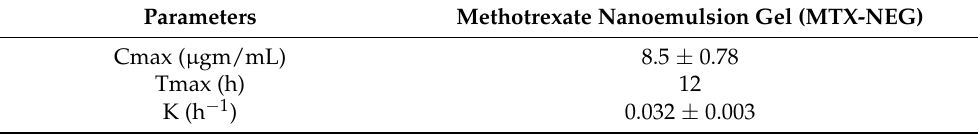
Table 8. Pharmacokinetic parameters of methotrexate from methotrexate nanogel upon administra- tion on skin in rabbits up to 24